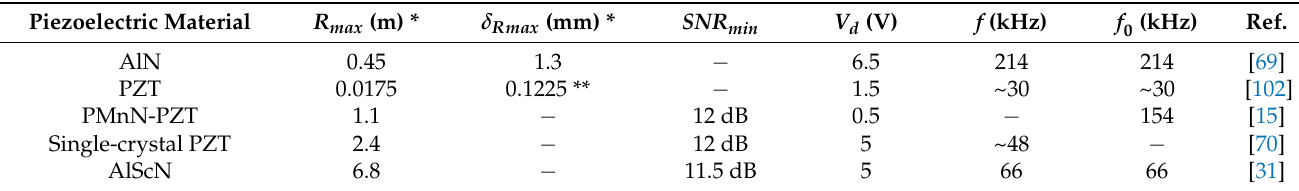
Table 6. Summary of pMUT rangefinders with different piezoelectric materials.